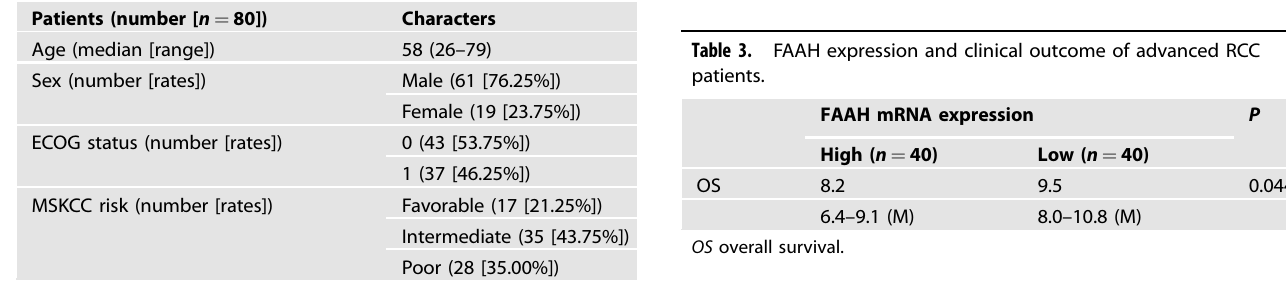
Table 1. Baseline information of patients.